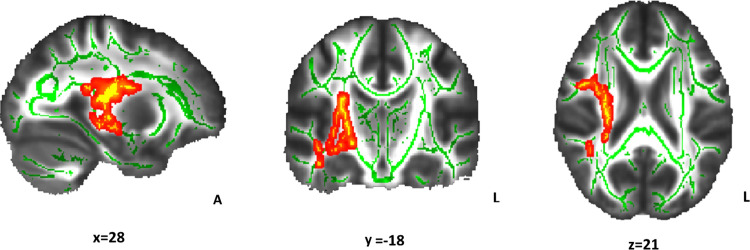
Relationship between Fractional Anisotropy (FA) and loss accuracy in the normal-weight group.The red-yellow color indicates the white matter clusters that showed a significant relationship between FA and loss avoidance accuracy (at the indicated coordinates). Increasing FA values regarding the loss accuracy increase are represented (α<0.05, threshold-free cluster enhancement and family-wise error correction). The mean skeleton of FA is shown in green. Right white matter tracts include the external capsule and superior and posterior corona radiata. Coordinates are presented in Montreal Neurological Institute (MNI) template space. A: anterior; L: left.